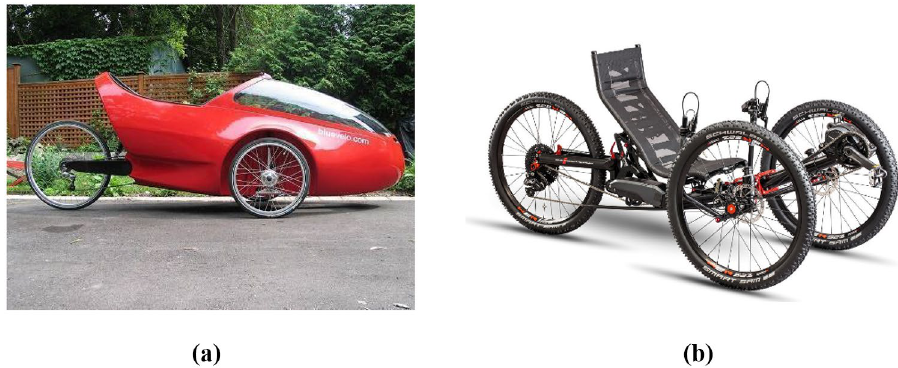
Fig. 2 Examples of recumbent cycles: a velomobile [12], and b trike